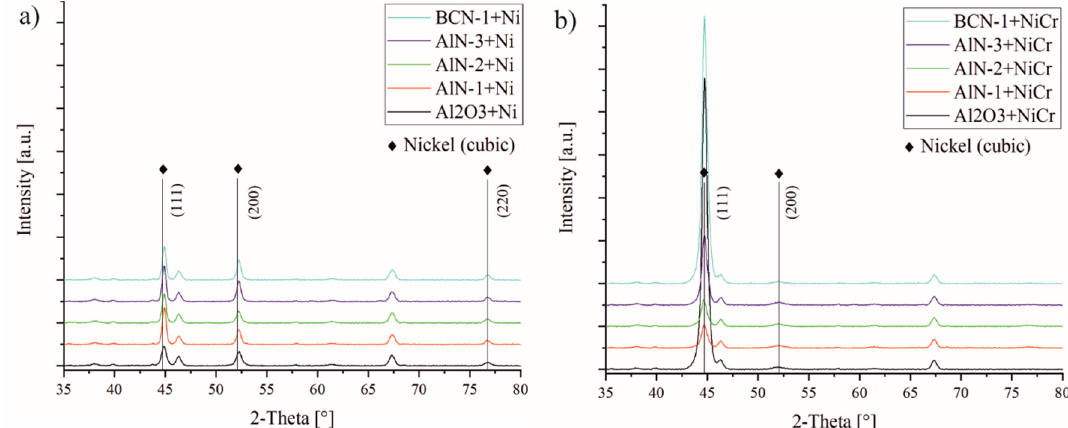
Figure 6. X-ray diffraction (XRD) patterns of the ( a ) Ni and ( b ) Ni-20Cr thin films, deposited on a polished Al 2 O 3 substrate as well as on AlN and BCN thin films.